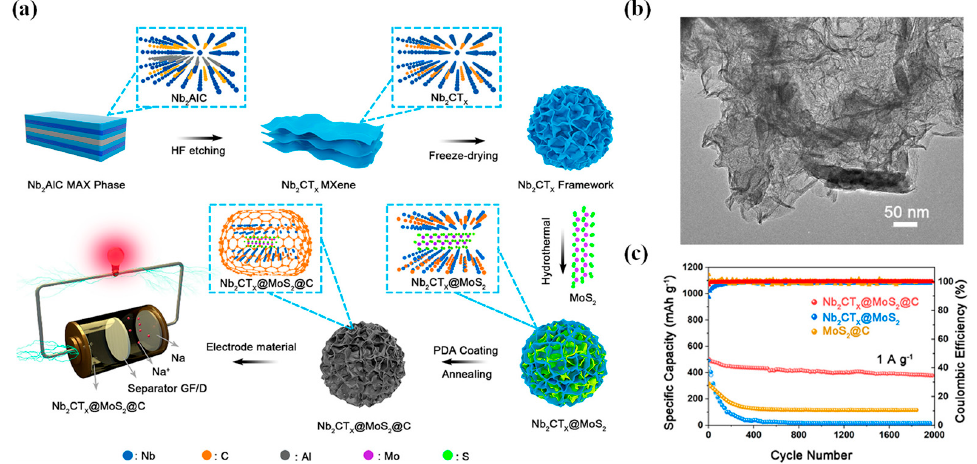
Figure 6. Applications of Nb 2 CT x in SIBs. ( a ) Schematic illustration of preparation of the